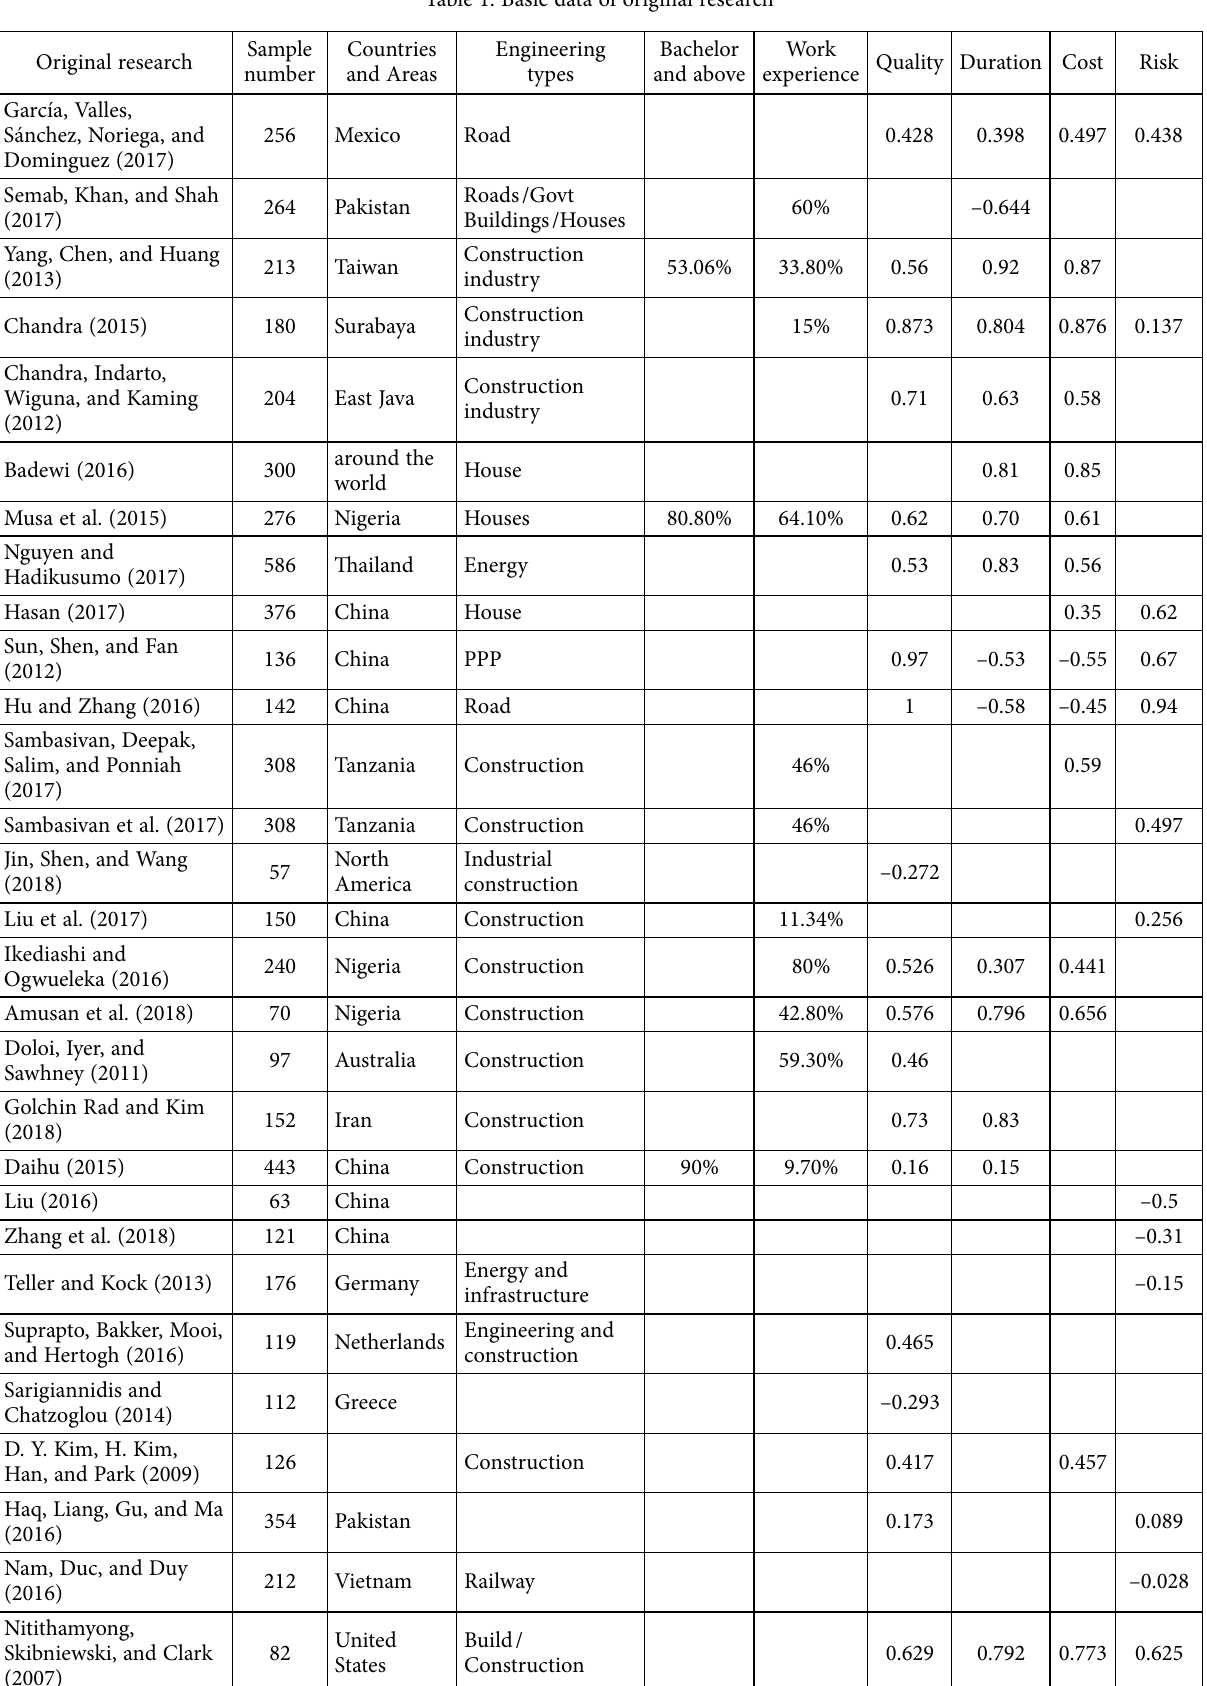
Table 1. Basic data of original